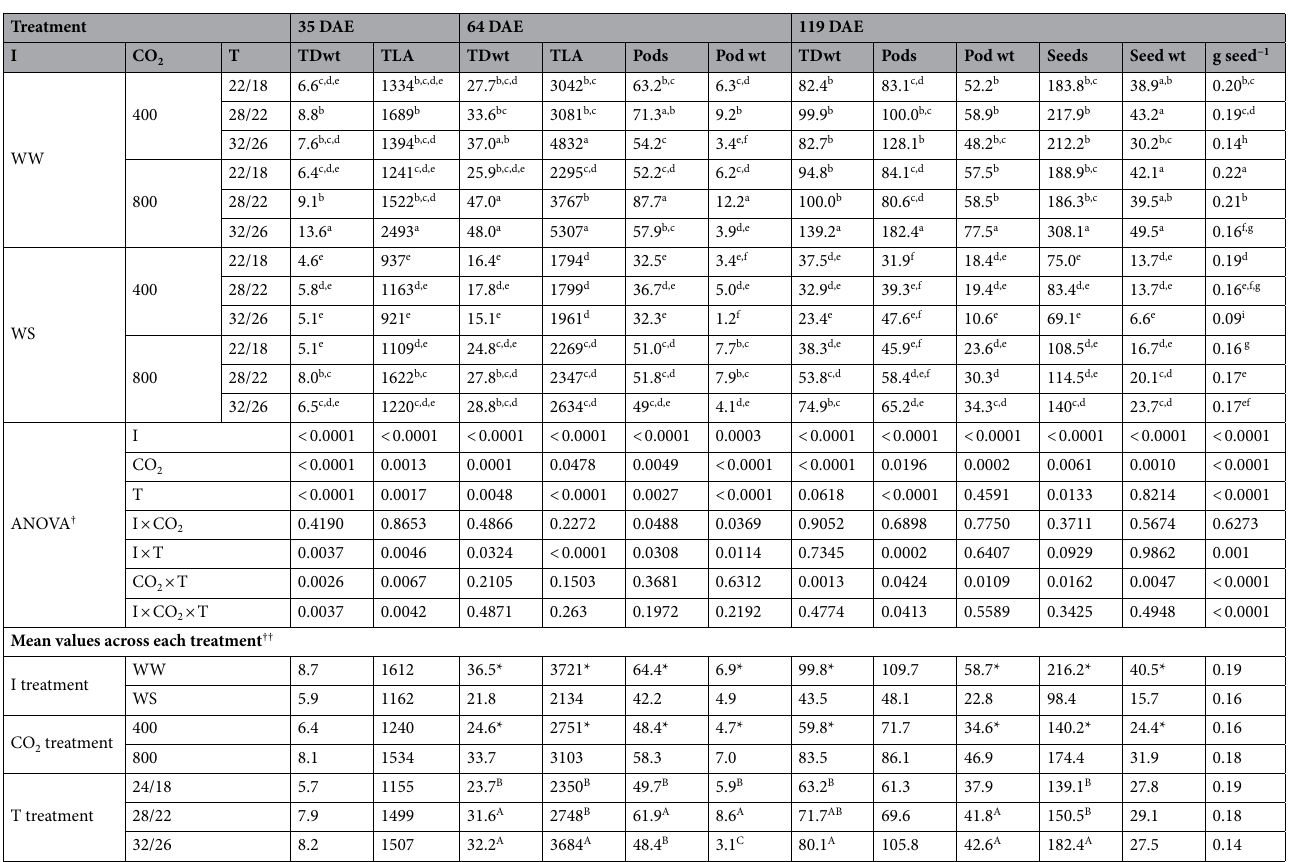
Table 2. Effects of irrigation (I, WW, well water; WS, water stress), CO 2 levels (µmol mol −1 ), and temperature (T, day/night, °C) treatments on plant total dry weight (TDwt, g plant −1 ), total leaf area (TLA, cm 2 plant −1 ), number of pods and seeds (plant −1 ), pod and seed dry weight (g plant −1 ), and seed size (g seed −1 ) at 35, 64 and 118 days after emergence (DAE). † The significance test (P-values) of the analysis of variance (ANOVA) across treatments and interactions are given. When the I × CO 2 × T interaction is significant, within a column means followed by the same lowercase letter are not significantly different. †† The means across each treatment is also given. When I × CO 2 × T interaction is not significant, the symbol * indicates a significant difference between values within either I or CO 2 treatments, and the mean value between T treatments followed by the same uppercase letter is not significant. Data are the mean (n = 18, 12, and 15 for 35, 64 and 119 DAE, respectively). Least significant difference at α =